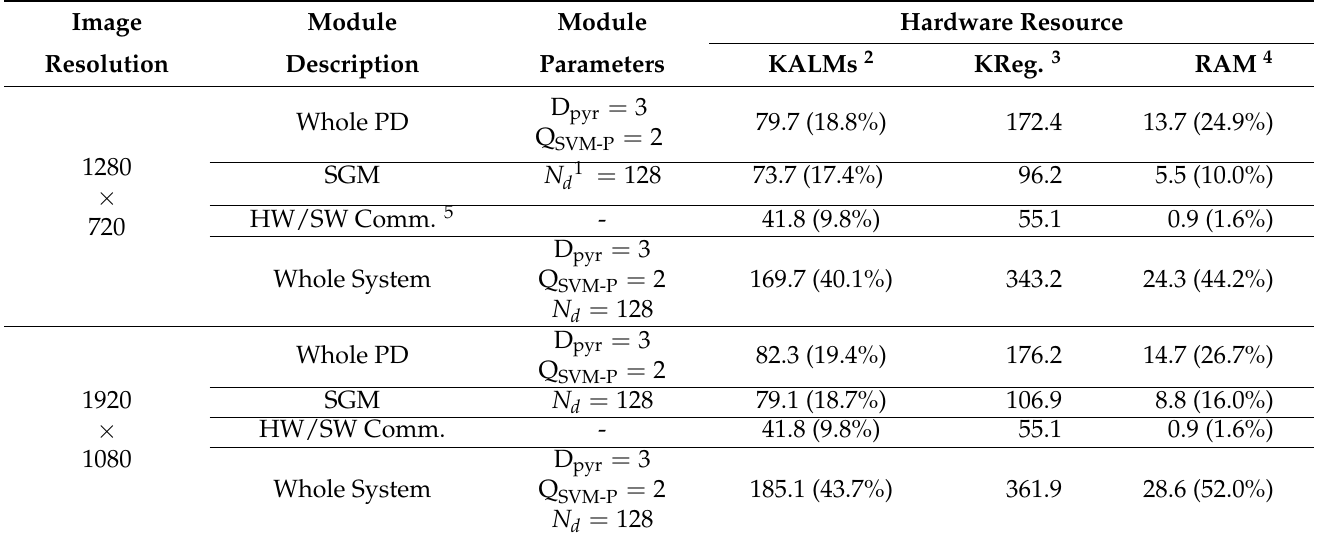
Table 3. Resource usage of the whole HW system that involves PD, SGM, and HW/SW